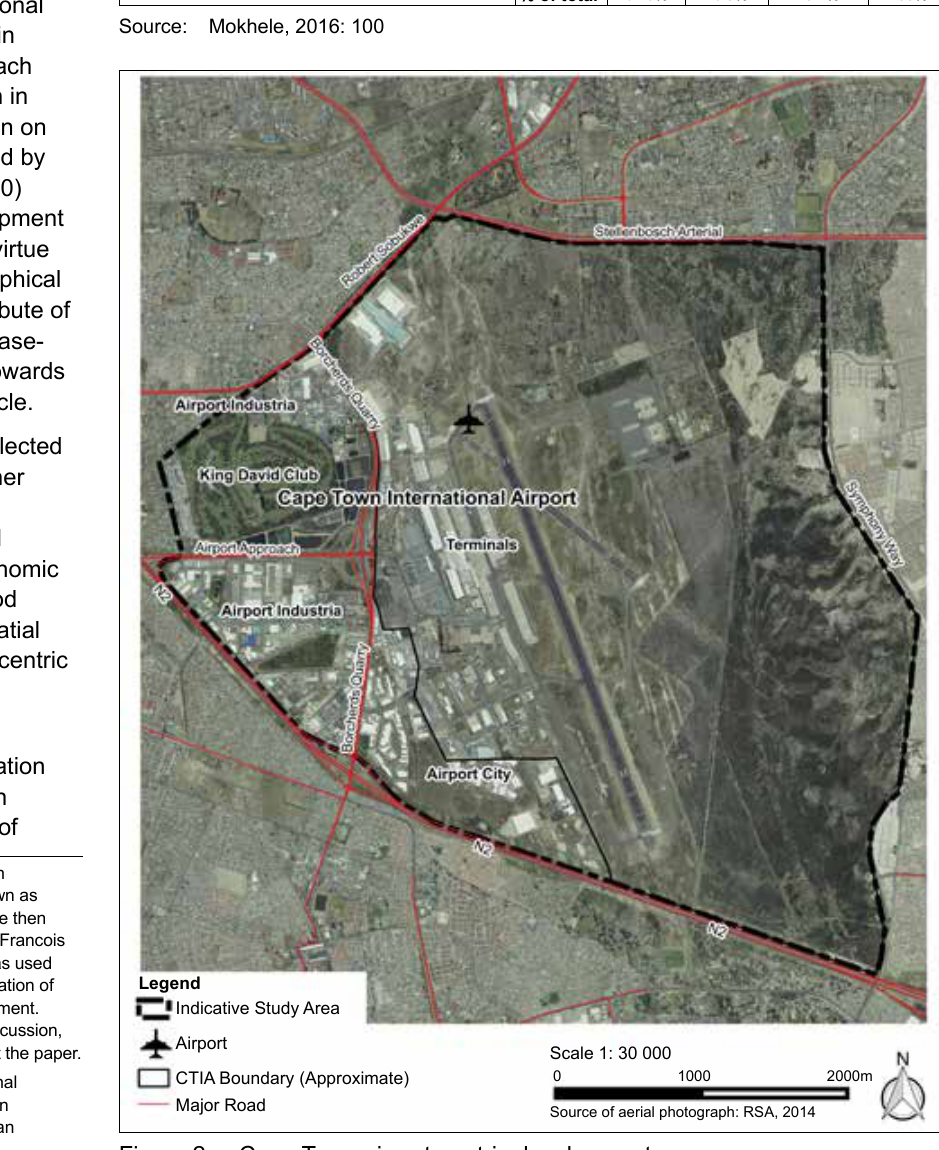
Figure 2: Cape Town airport-centric development Source: Adapted from Mokhele, 2016: